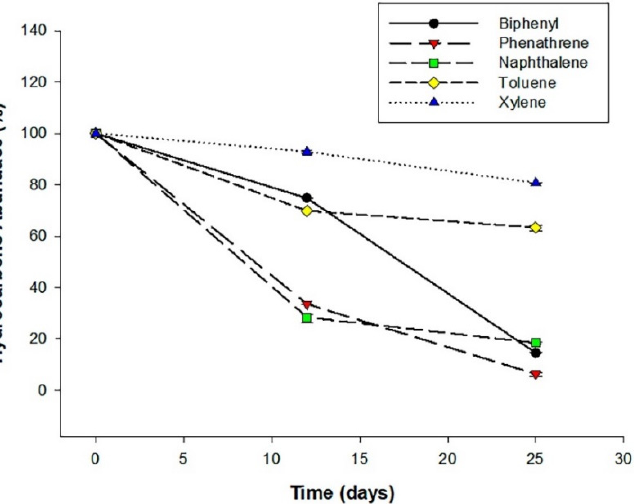
Figure 2. Degradation of hydrocarbons by S. yanoikuyae S72. Hydrocarbon abundance (%) of five polycyclic aromatic hydrocarbons (PAHs) in liquid Bushnell Haas medium supplemented with each of the five different hydrocarbons (100 µg/mL) as sole source carbon.